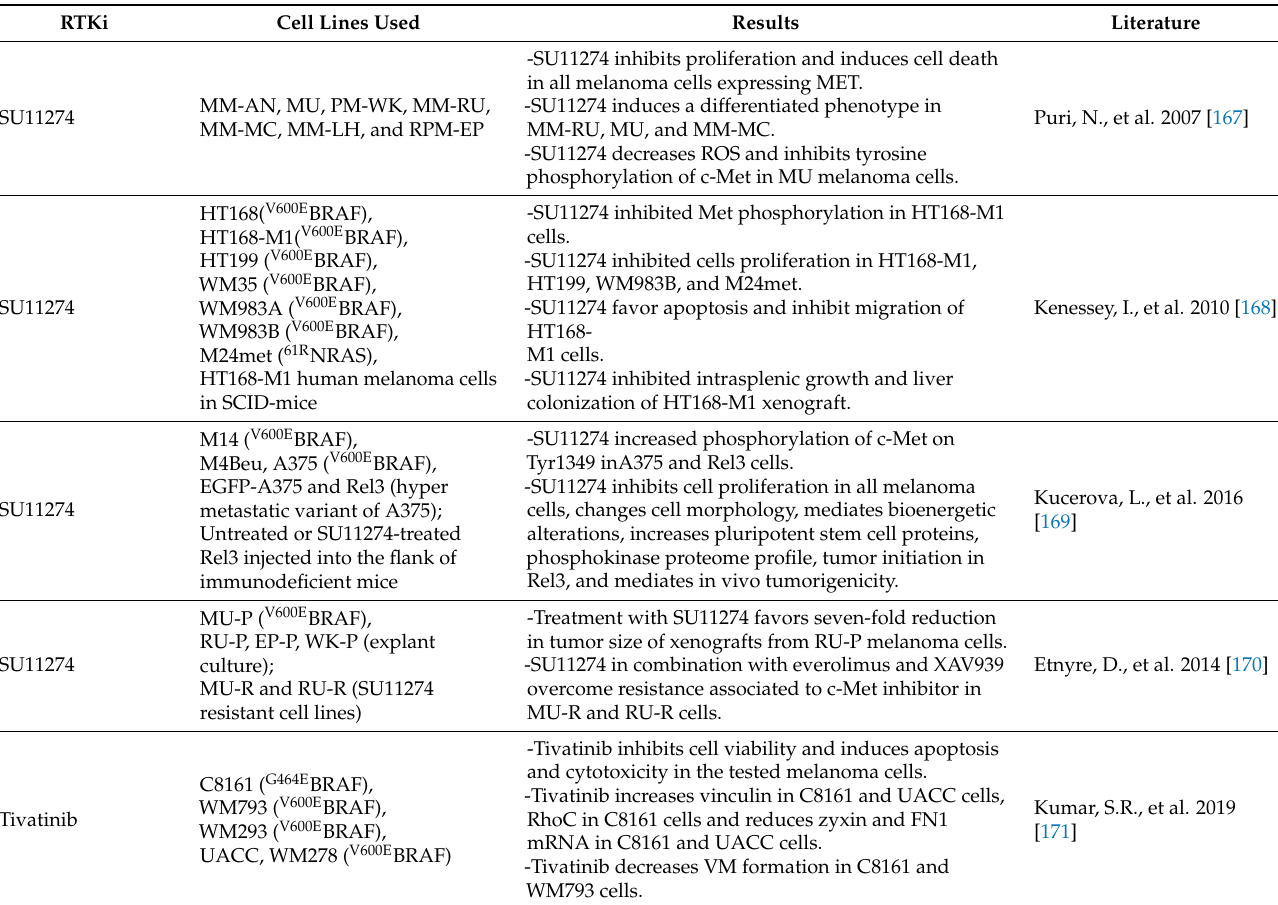
Table 8. Met inhibitors in melanoma preclinical